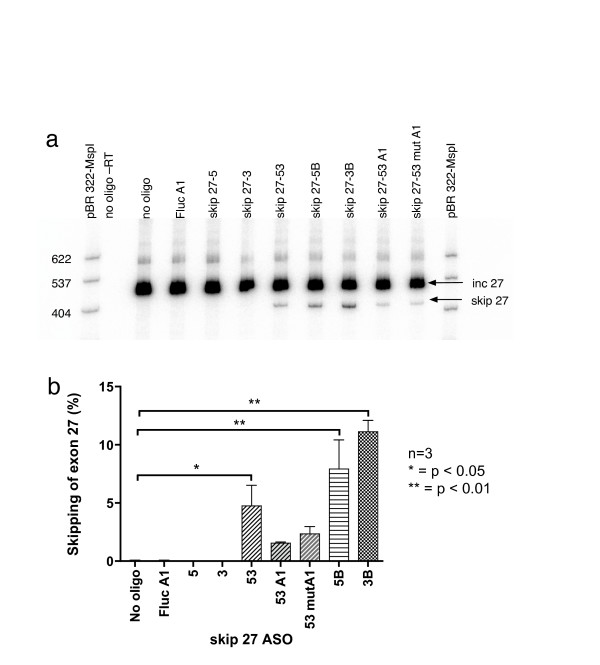
Alternative splicing of exon 27 induced by APOB exon 27 splice-site ASOs. (a) HepG2 cells were transfected with the indicated ASOs at 250 nM for 48 hours. RT-PCR was carried out on the total RNA extracted from these cells with oligonucleotides annealing to the adjacent exons 26 and 28. The -RT control PCR was performed without reverse transcriptase. The positions of the bands corresponding to the APOB mRNA species with exon 27 (inc 27) and without exon 27 (skip 27) are indicated on the right side. Fragment lengths in bp of pBR322-MspI markers are indicated on the left side. The band corresponding to skip 27 mRNA was cloned and sequenced to confirm that exon 26 is spliced to exon 28. (b) The graph shows the quantitative data from three independent replications of the experiment (error bars show the S.E.M.). Overall one-way repeated measures ANOVA p-value was < 0.0001, indicating statistically significant differences between groups. Dunnett's multiple comparison test was used to compare the no-oligo control versus ASO-transfected cells: statistically significant differences were found with skip 27–53, skip 27-5B, and skip 27-3B.